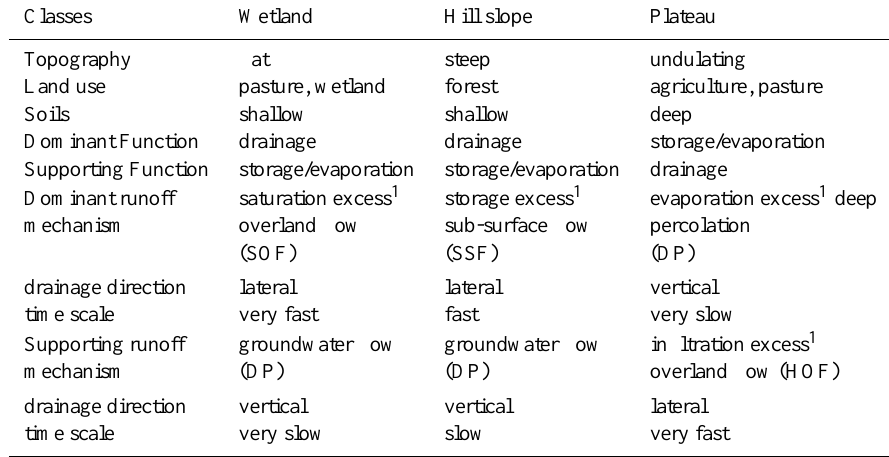
Table 1. Characteristics of the Wetland–Hill slope–Plateau system.